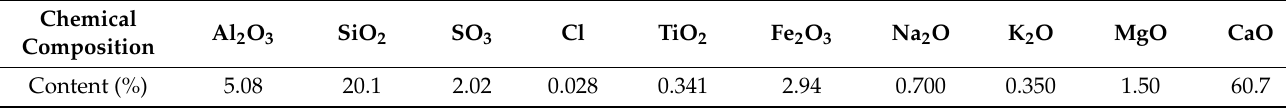
Table 1. Chemical composition of cementitious materials.